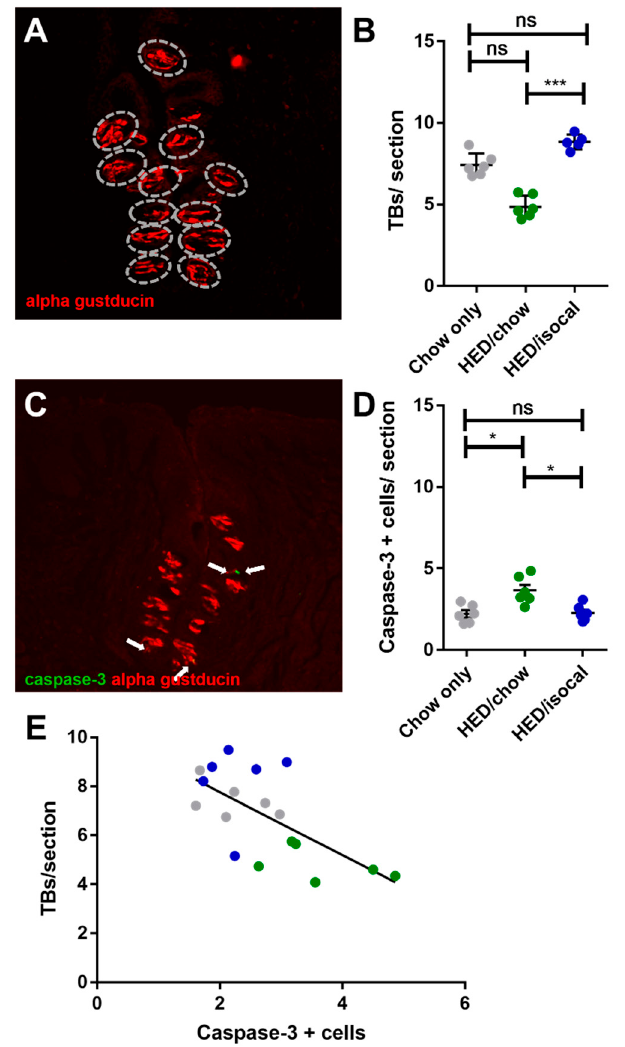
Figure 3. ( A ) Representative image of circumvallate papilla with α -gustducin (red) staining higlighting taste buds. ( B ) Number of taste buds (TBs) per CV section for all treatment groups. Chow-only (grey, n = 6), high-energy diet (HED) then chow (green, n = 7), and HED then HED isocaloric (blue, n = 6). Overall p = 0.029. Y-axis shows taste buds per section. ( C ) Representative image of circumvallate papilla showing caspase-3 (green), α -gustducin (red). ( D ) Caspase-3 positive cells per CV section for all treatment groups. Chow-only (grey, n = 6), HED then chow (green, n = 7), and HED then HED isocaloric (blue, n = 6). Bars represent means plus/minus SEM. Overall p = 0.001. ( E ) Number of taste buds/ section (y-axis), caspase + cells (x-axis). Chow-only (grey, n = 6), HED then chow (green, n = 7), and HED then HED isocaloric (blue, n = 6). Pearson’s r = − 0.662, p = 0.003. ns denotes non significant; * denotes p < 0.05; *** denotes p <